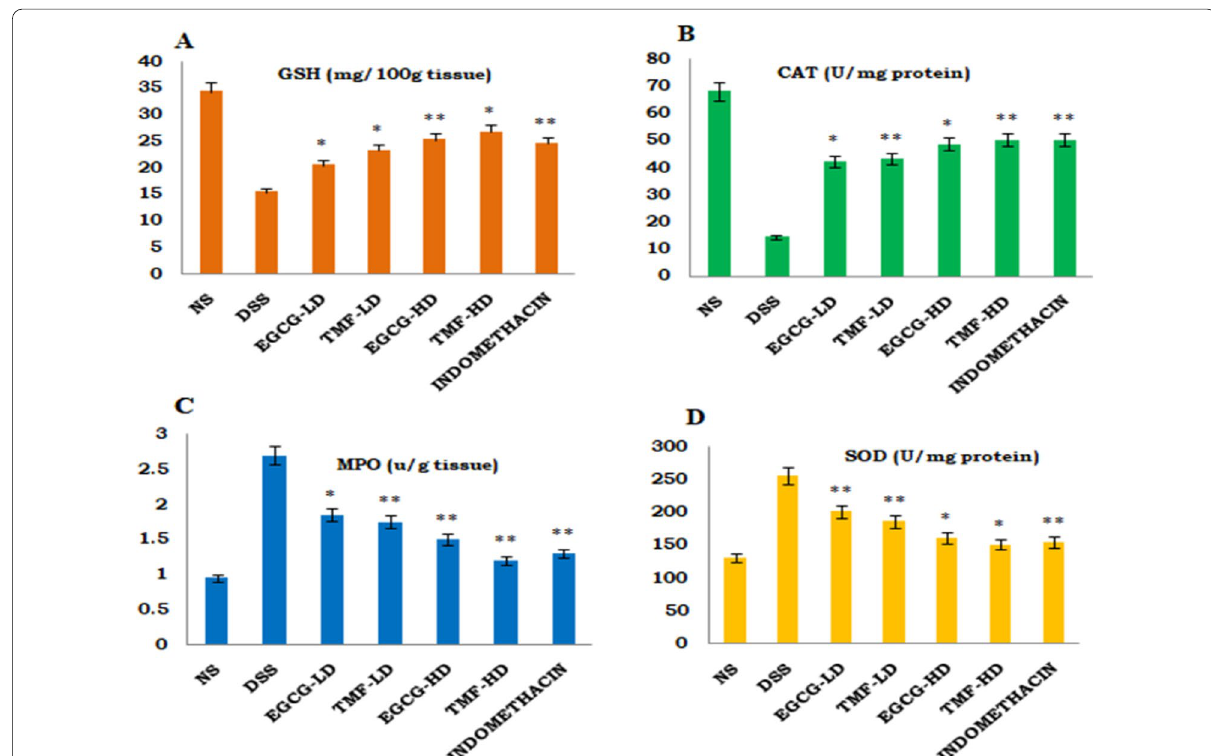
Fig. 8 MPO of inflamed tissue and SOD, GSH, and CAT levels in the hepatic tissue of rats in the chronic inflammatory